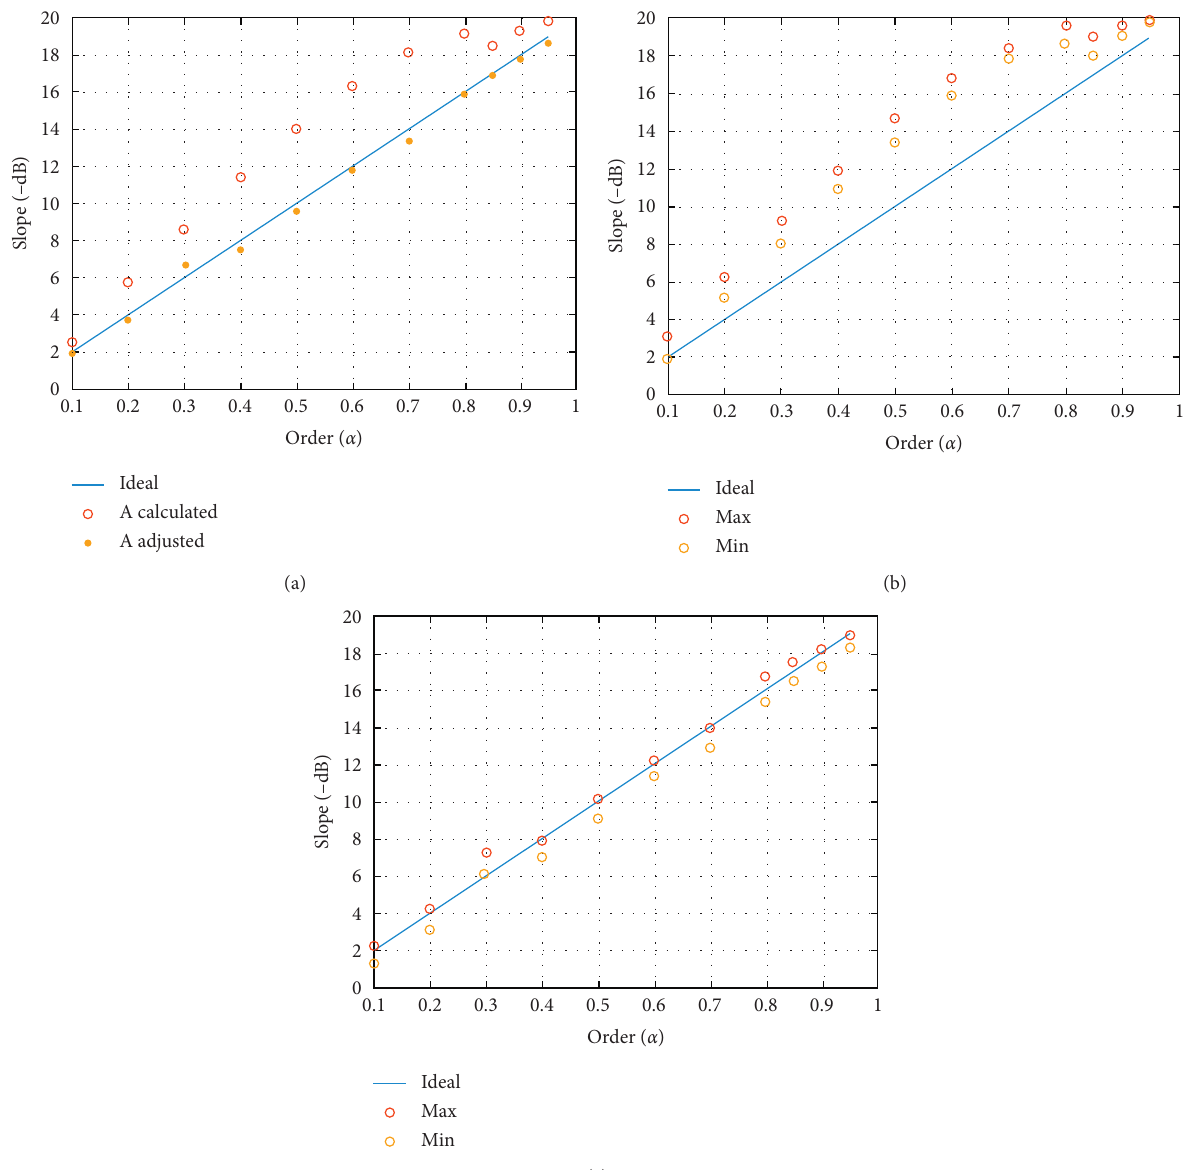
Figure 7: Monte Carlo analysis: (a) mean values of slope with and without adjustment. (b) Maximum and minimum values of slope without adjustment. (c) Maximum and minimum values of slope with adjustment.